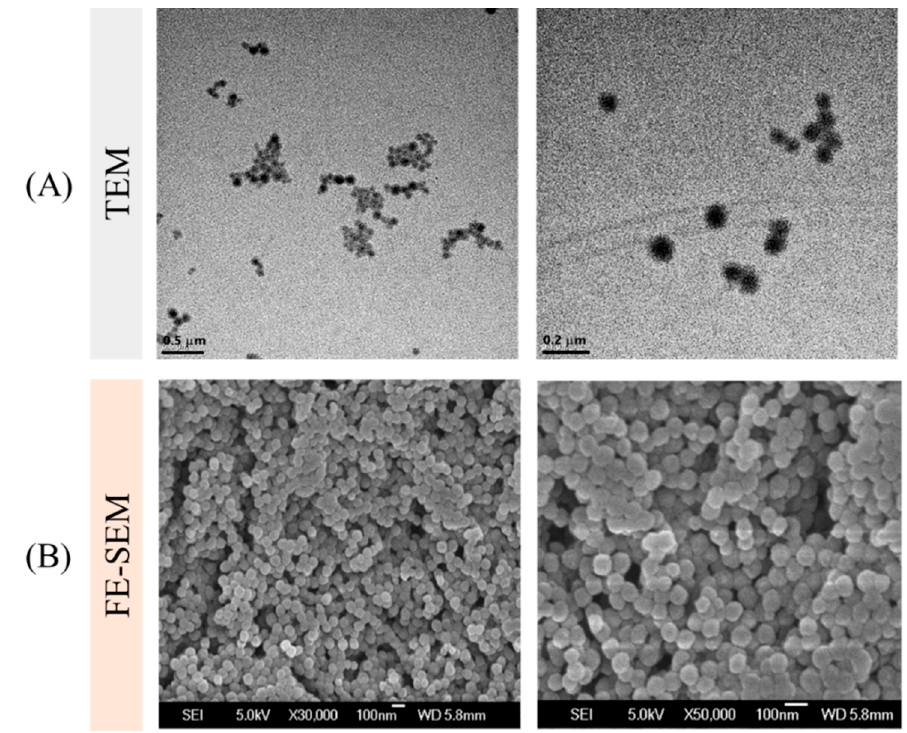
Figure 3. Electron microscopy images of GONs at two different magnifications (×30K and ×50K): ( A ) TEM and ( B ) FE-SEM.